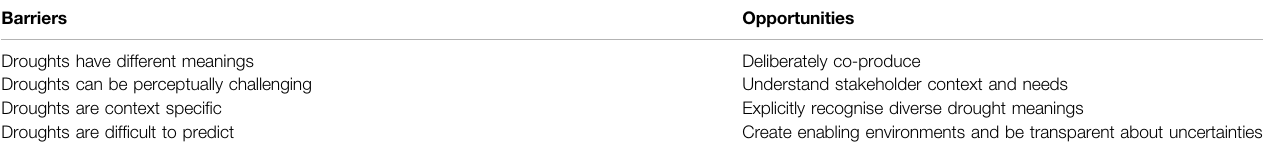
TABLE 1 | Barriers to and opportunities for actionable knowledge production in drought risk management.